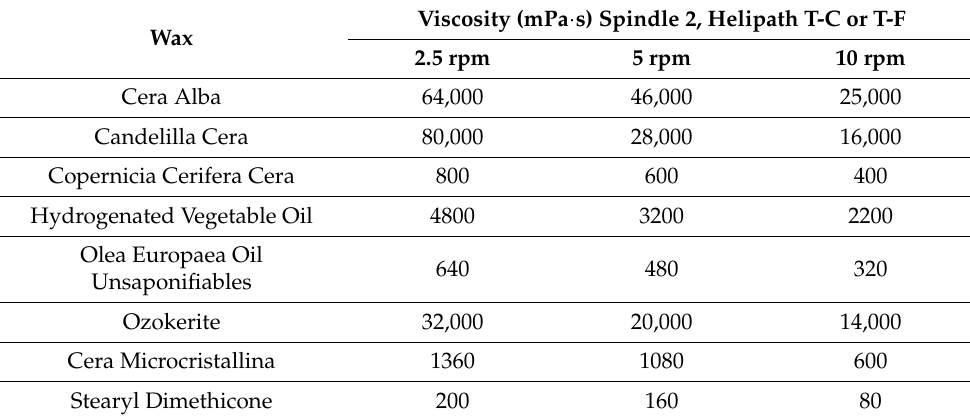
Table 4. Viscosity values of the new oil containing 10% waxes at